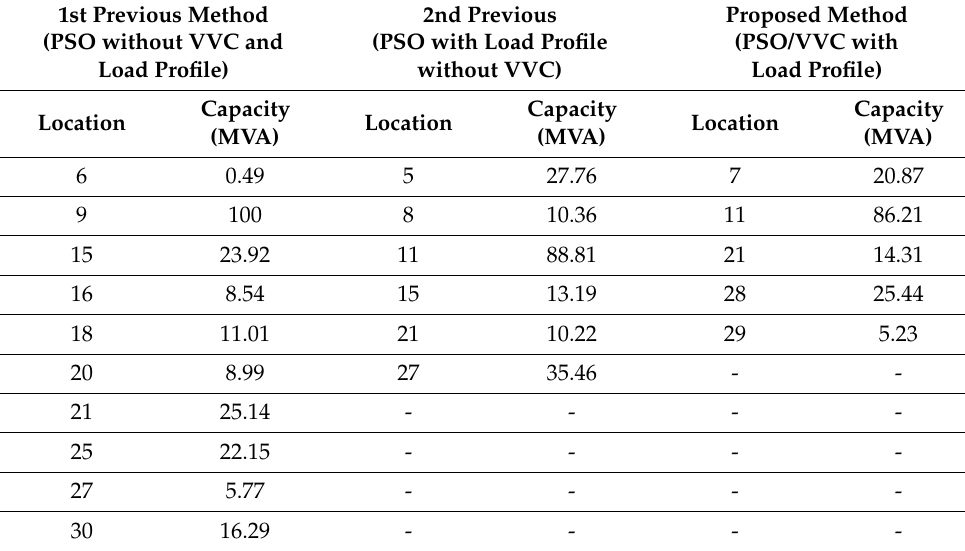
Figure 6. Convergence of objective function (IEEE 30-bus test feeder). Table 2. Optimal location and capacity of DG (IEEE 30-bus test feeder).